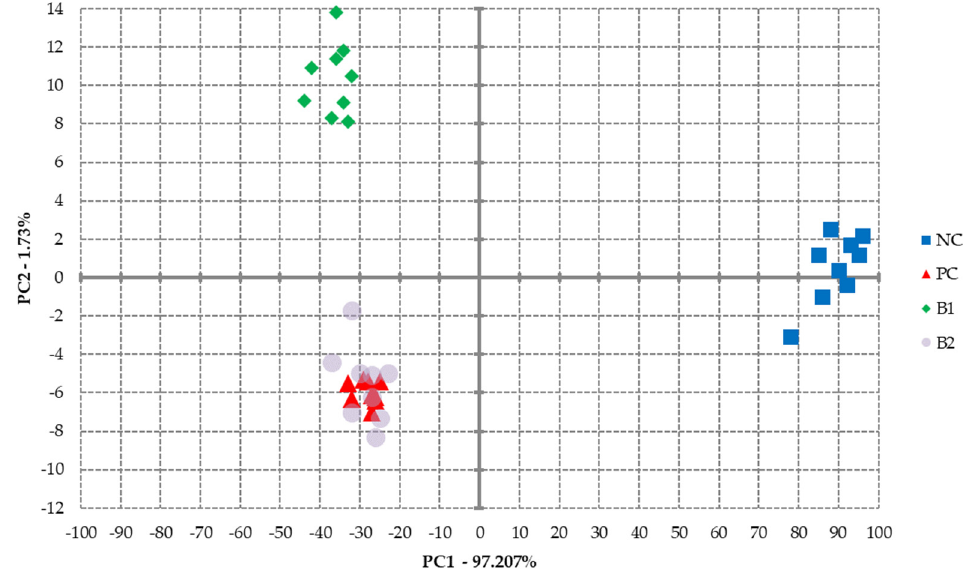
Figure 5. PCA analysis of cooked pork loins; NC—negative control (pork loins soaked in nitrite-free brine); PC—positive control (pork loins soaked in brine containing sodium nitrite); B1—pork loins soaked in brine containing plasma-activated powder of cow milk; B2—pork loins soaked in brine containing plasma-activated powder of soy milk. Table 3. Volatile compounds’ characteristic of pork loins cured with alternative nitrite